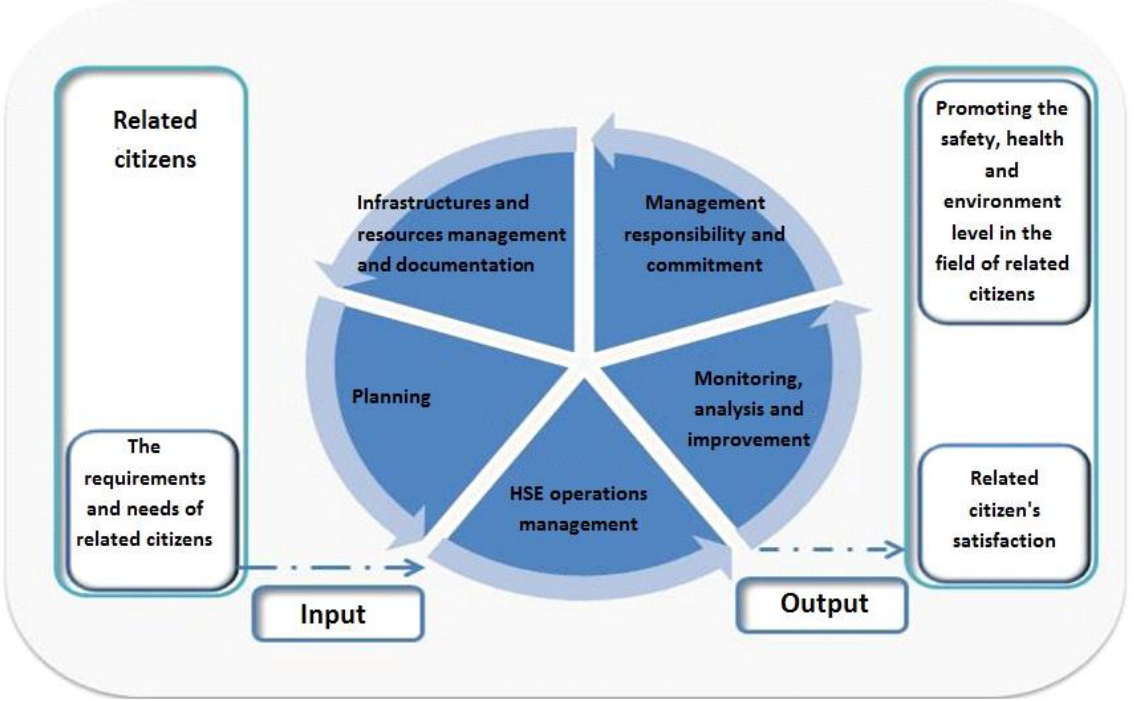
Fig. 3: The model of citizenship HSE